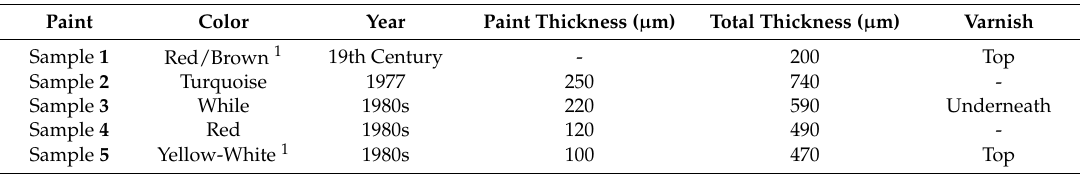
Table 1. Summary of oil paint samples 1 – 5